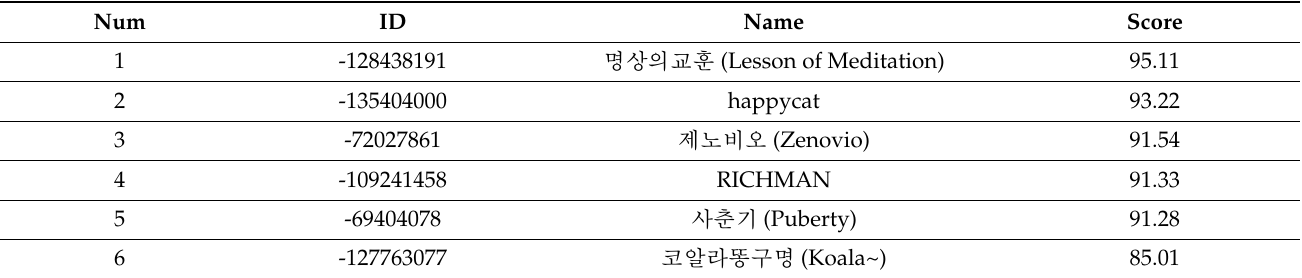
Figure 6. Comparison of comment similarity. Table 4 lists users whose scores are greater than 80. Table 4. Top 6 users by similarity